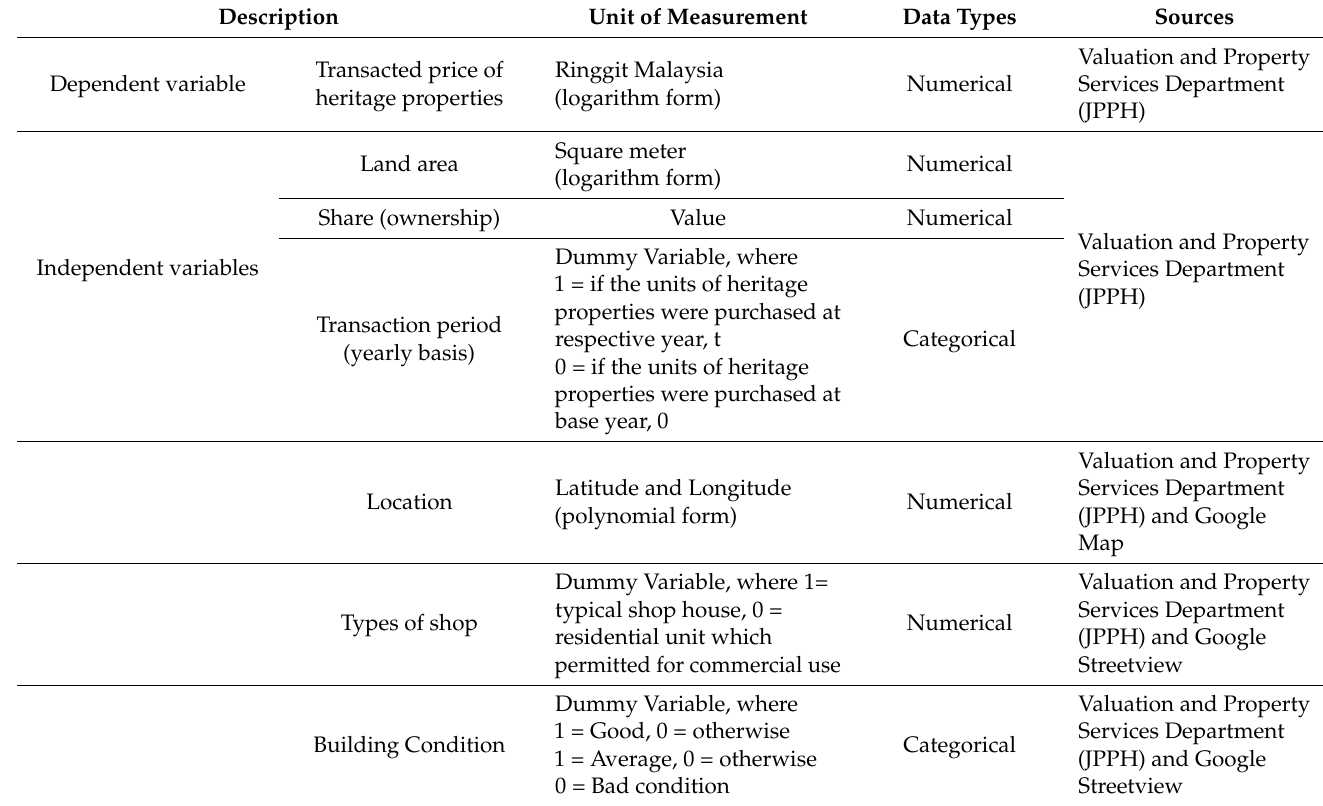
Table 1. Data Quantification for Hedonic Price Index